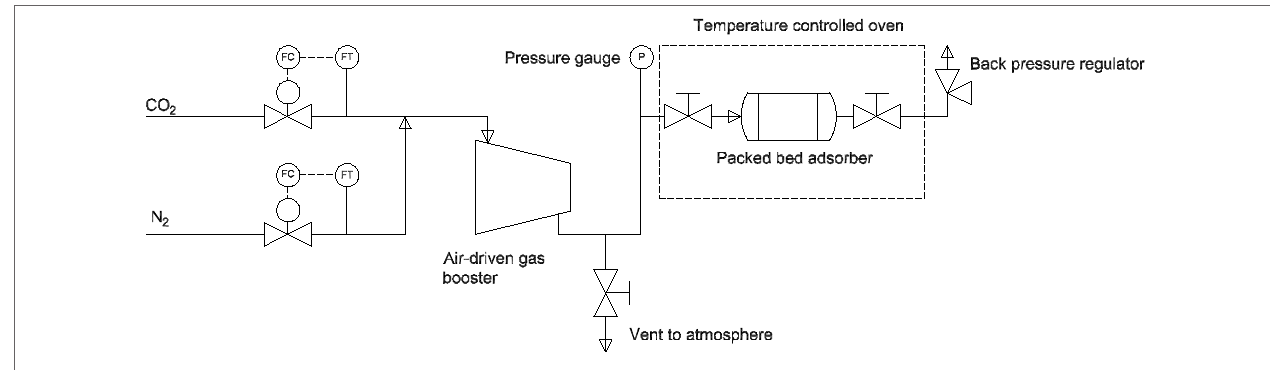
FigUre 2 | Pressure swing adsorption experimental rig used for measuring sorbent capacity, rate, and separation